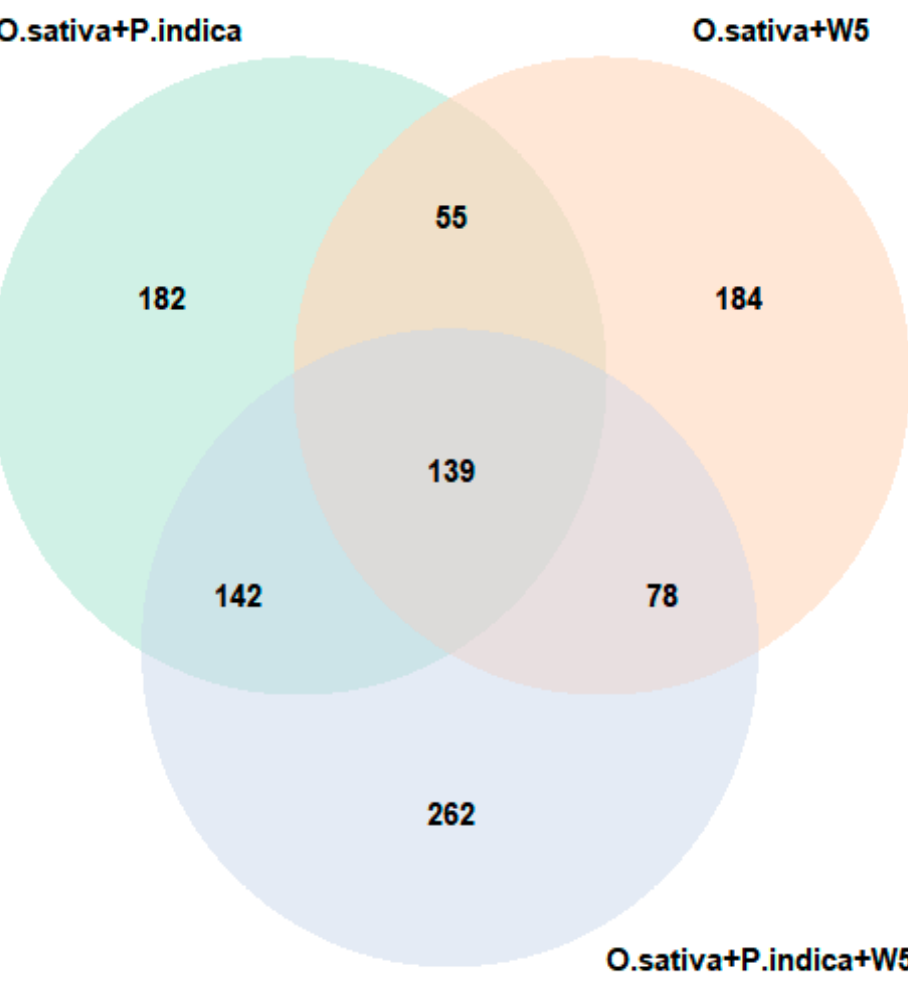
Figure 5. Venn diagram showing significantly ( p -value, p ≤ 0.05) differentially abundant proteins that were identified in O. sativa under three different conditions of plant microbial interactions.